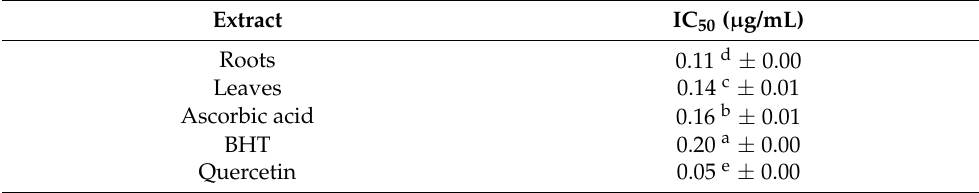
Table 2. Values IC 50 from the DPPH test.